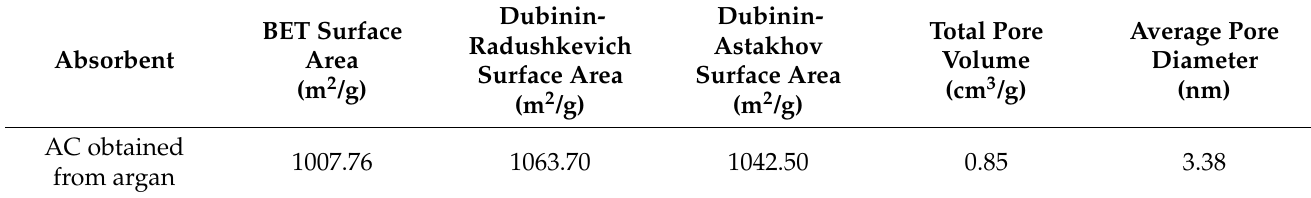
Figure 5. ( a ) Nitrogen adsorption/desorption isotherms; ( b ) pore size distribution with insert in the region of pore diameter between 0 and 100 nm for AC based on argan nutshells. Table 3. Textural properties of the activated carbons obtained from argan.